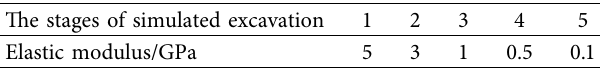
Table 2: Deformation modulus used in different